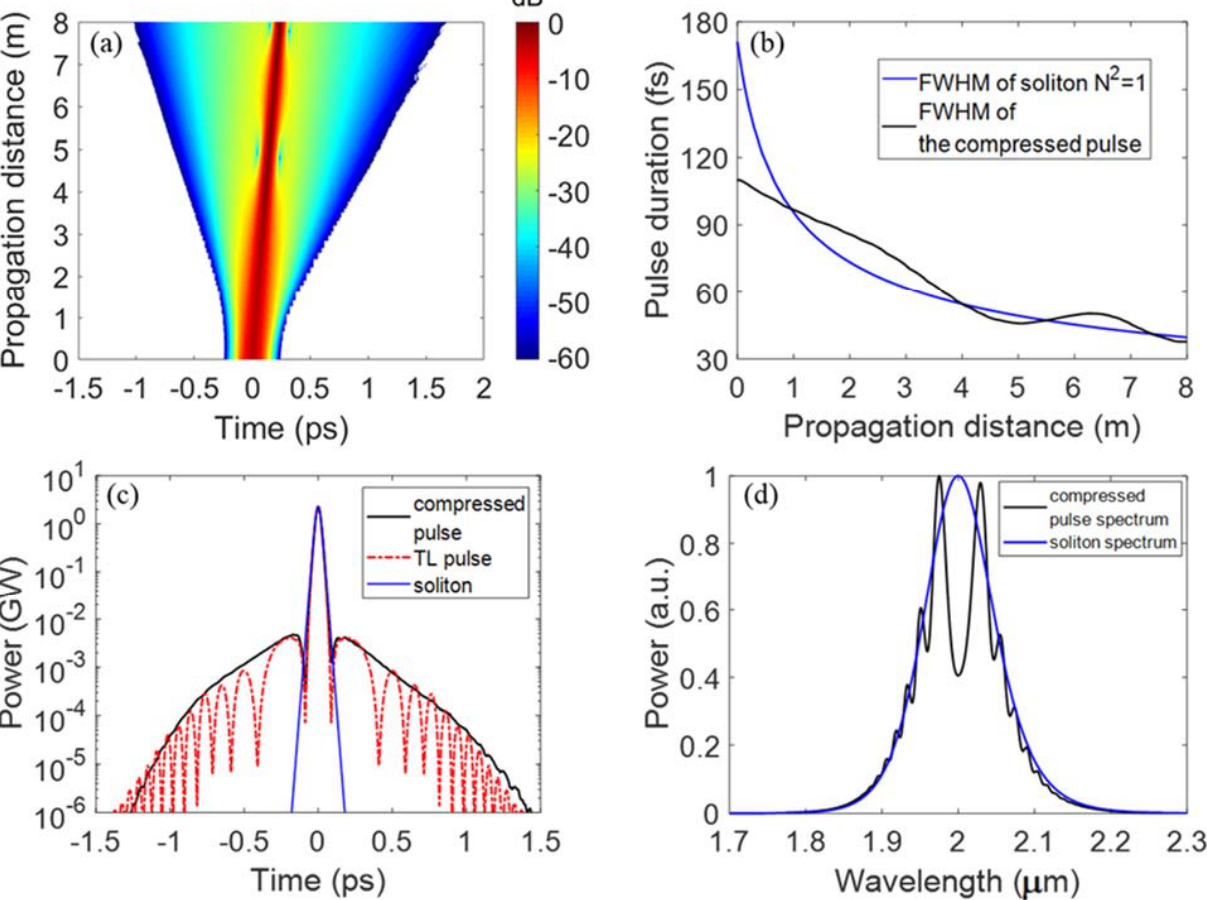
Figure 3. ASC of an unchirped 110 fs, 100 μ J pulse at 2 μ m. ( a ) Pulse evolution as a function of propagation distance. The intensity is shown in log scale. ( b ) FWHM of a fundamental soliton (blue curve) and FWHM of a compressed pulse (black curve) versus the propagation distance. ( c ) Compressed pulse (black curve) and transform-limited (TL) pulse (red dashed curve) at HCF output. The fundamental soliton is shown as the blue curve. ( d ) Optical spectrum (black curve) and soliton spectrum (blue curve) at HCF output.